Question: Which kind of chart has been used to present this data?
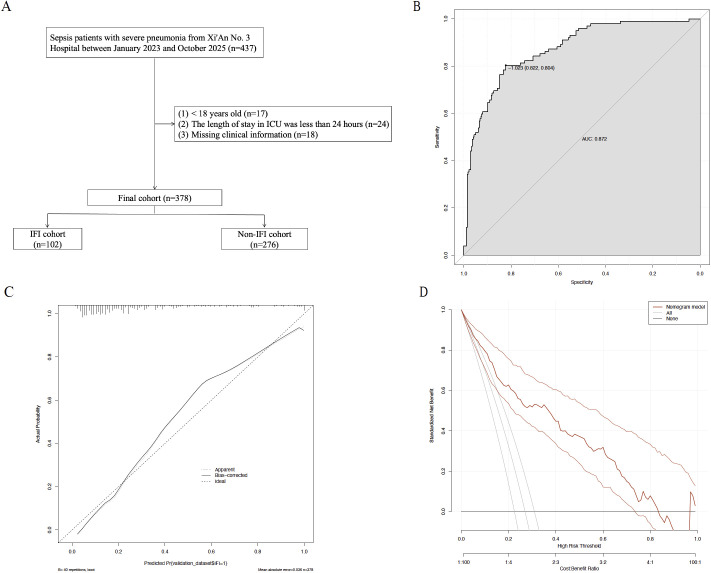
Answer: line